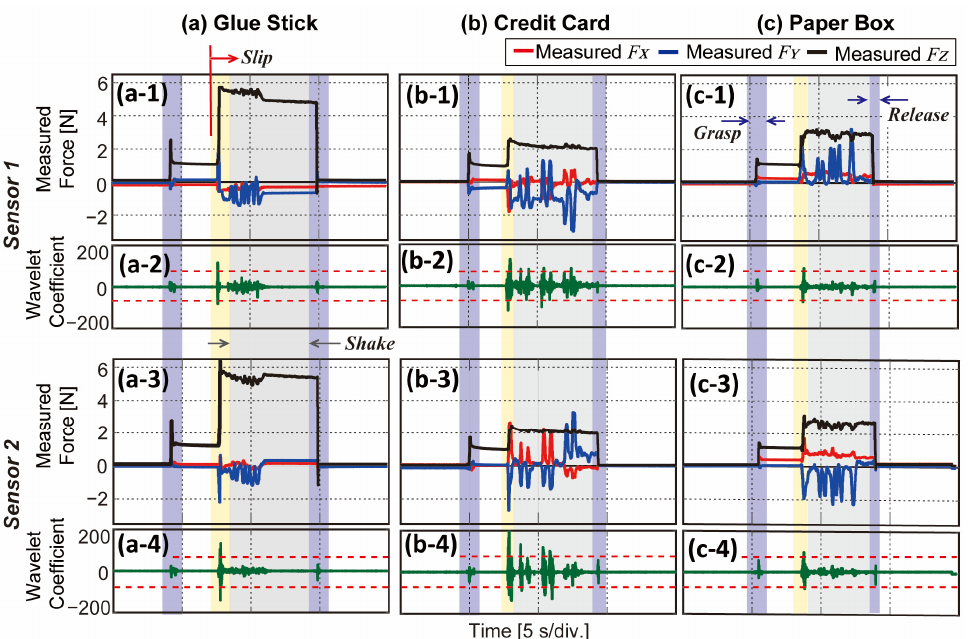
Figure 12. Experimental results of slip detection experiment with external interfering force. ( a ) Re- sults of glue stick grasping. ( b ) Results of credit card grasping. ( c ) Results of paper box grasping. ( a1 , b1 , c1 ) Three-axis measured force from sensor 1 and ( a3 , b3 , c3 ) from sensor 2. ( a2 , b2 , c2 ) DWT results with threshold from sensor 1 and ( a4 , b4 , c4 ) from sensor 2, respectively.